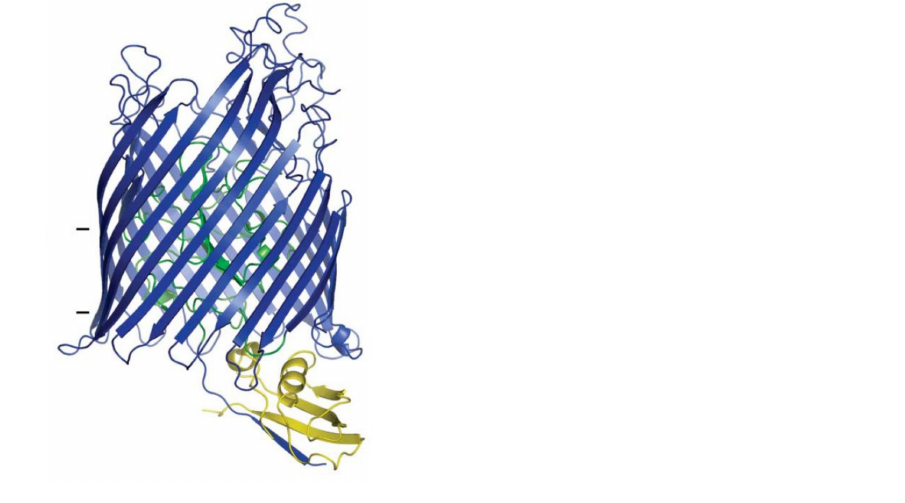
Figure 3. Structure of the complex formed between FhuA and TonB. The proteins FhuA and TonB are represented in cartoon. The C-terminal domain of TonB (residues 158–235) is colored in yellow. The plug domain of FhuA (residues 19–160) is colored in green. The rest of the molecule (residues 8–18 and 161–725) is colored in blue. Horizontal bars delineate approximate outer membrane boundaries. [Reproduced with permission from Pawelek et al. (2006) [34] and agreement from the American Association for the Advancement of Science and Copyright Clearance